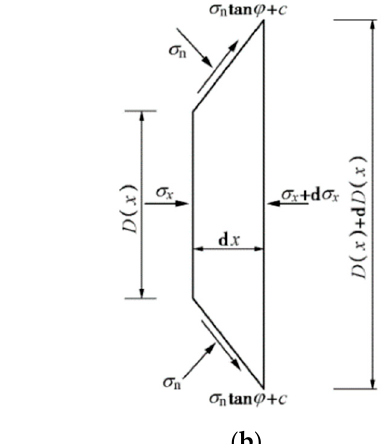
Figure 4. Calculation model using an improved Ito theory.